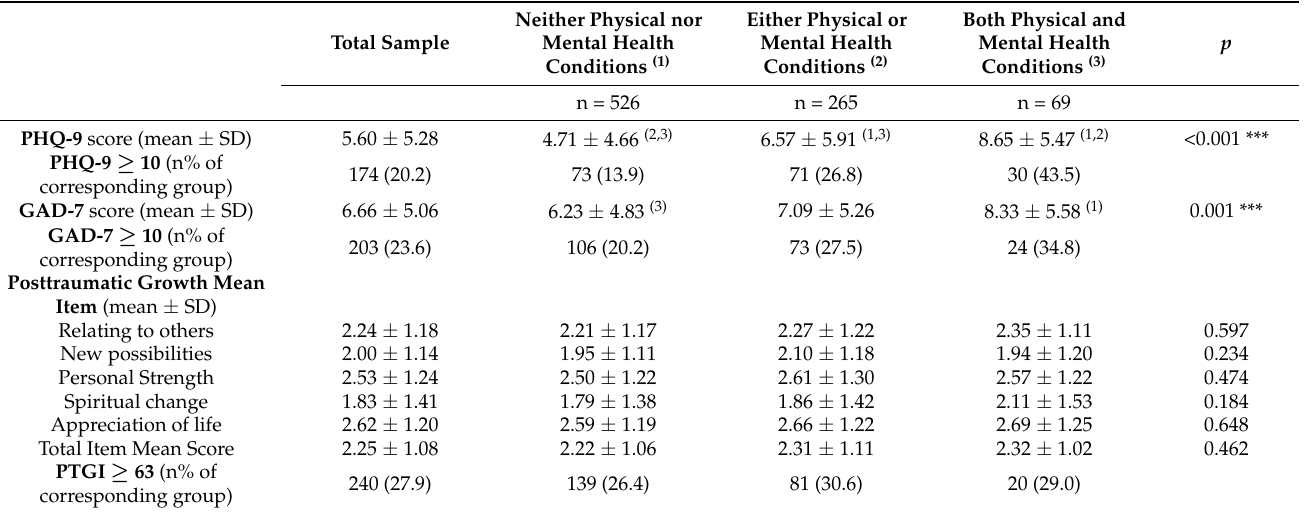
Table 2. Depressive and anxiety symptoms and posttraumatic growth in total sample and by health groups